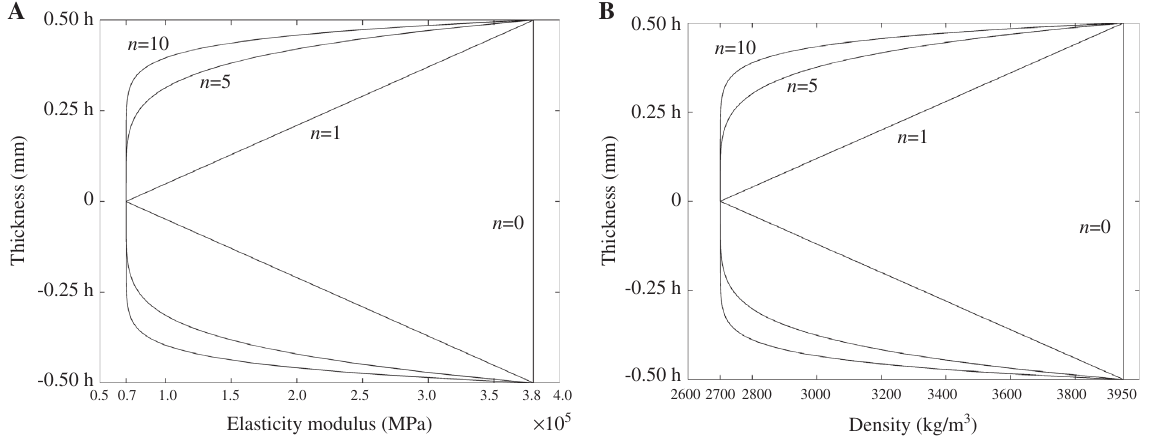
Figure 2 Variations of elasticity modulus (A) and mass density (B) through the thickness for different index values of power law